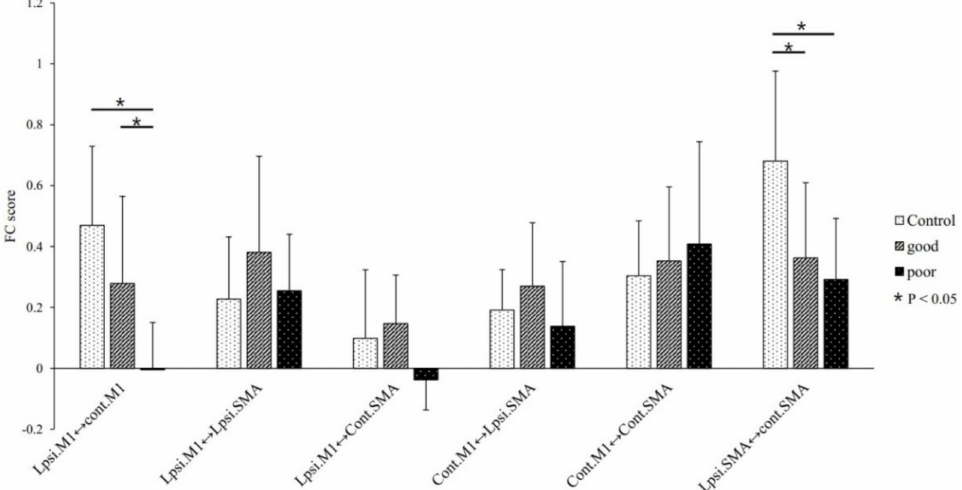
Figure 2. ANOVA F-tests showed significant di ff erences in functional connectivity (FC) between ipsilesional M1-contralesional M1 among the three groups ( p = 0.00039). Post-hoc two-sample t-tests were performed for further comparing between the groups. The good recovery group showed a higher FC than that shown by the poor recovery group ( p = 0.034). In contrast, no significant di ff erence in FC was seen between the good recovery and the healthy control groups ( p = 0.182). Additionally,